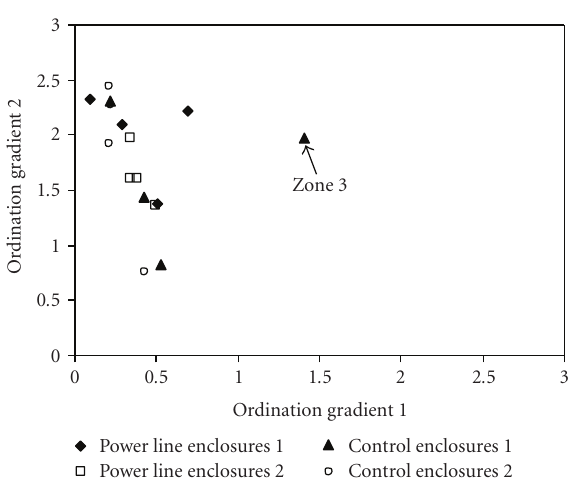
Figure 2: Plot of the four zones of the four enclosures (Power line 1 and 2, and Control 1 and 2) along the two ordination gradients with the highest explanatory power in a detrended correspondence analysis of plant species cover. All zones have similar vegetation, with a possible exception for zone 3 in control enclosure